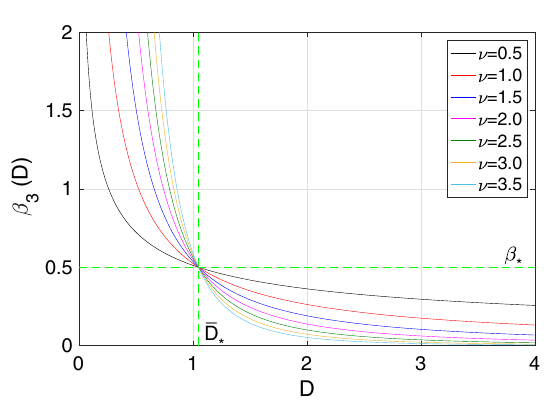
Figure 2. The transmission rate functional form for β 3 ( D ) is pictured. The scaling distance was taken to be ¯ D ∗ = 1.05 for all transmission rates, which was considered to be an average of the distance types D_* from Table 1. The base line transmission rate was chosen to be β ∗ = 0.5